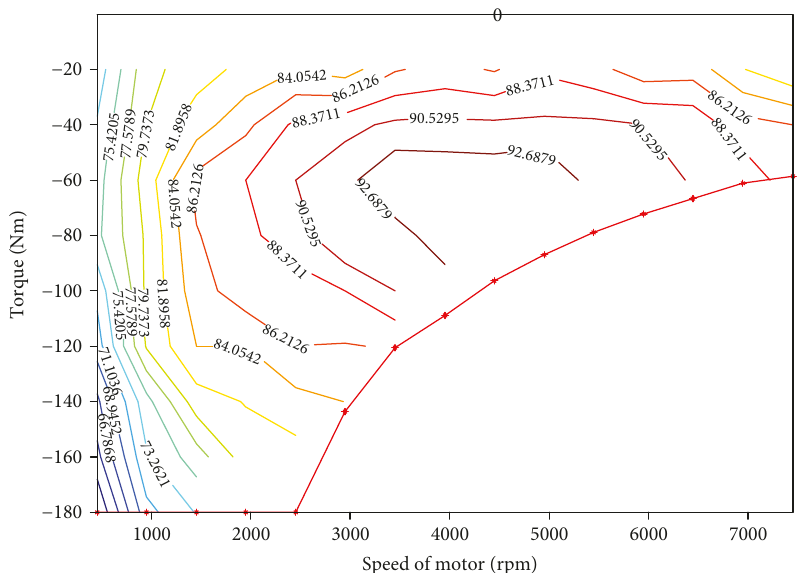
Figure 6: Motor prediction map characteristic